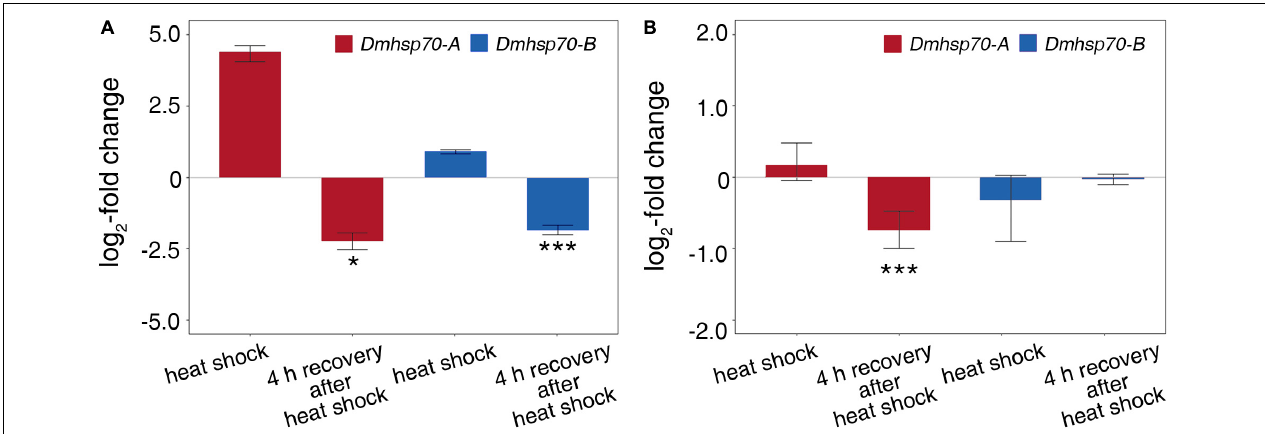
FIGURE 4 | Relative fold change (in log 2 scale) in transcripts level of Dmhsp70-A and Dmhsp70-B upon heat shock in developing cells from D. magna asexually produced embryos (A) and diapausing cells from D. magna sexually produced embryos (B) . Displayed is expression at each treatment relative to non-stressed control treatment. Error bars represent standard error ( n = 3). P -values are indicated by asterisks: * P ≤ 0.05, *** P ≤